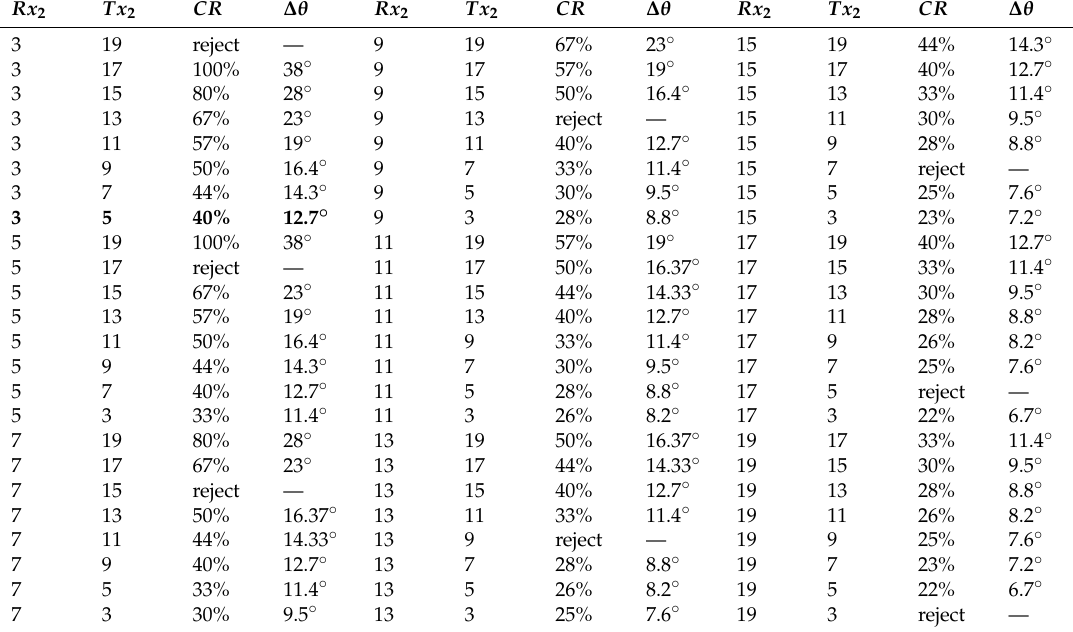
Figure 1. Schematic representation of the CS-MIMO antenna configuration. Crosses represent the positions of virtual antennas; black numbers on grid refer to the CS aperture, red numbers to physical positions. Table 1. TX 2 / RX 2 antennas positions along with their CR when RX 1 is in position #1, and TX 1 is in position #21. The bold one corresponds to the developed prototype